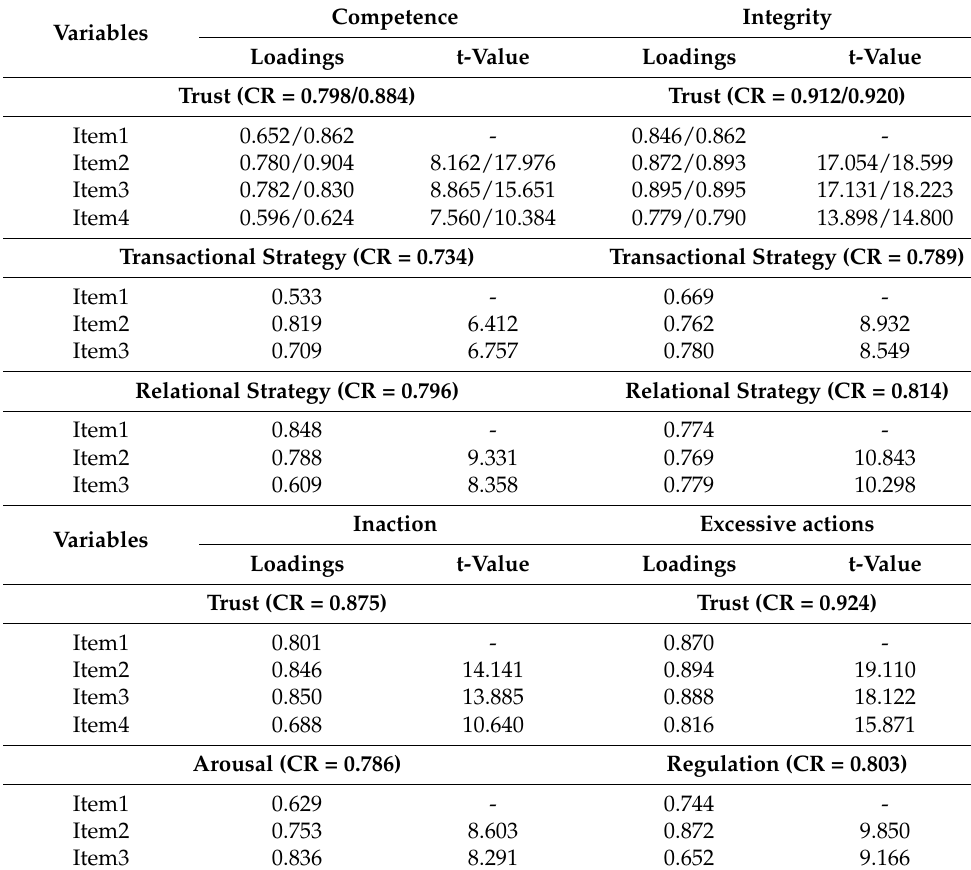
Table 2. Confirmatory factor analysis.